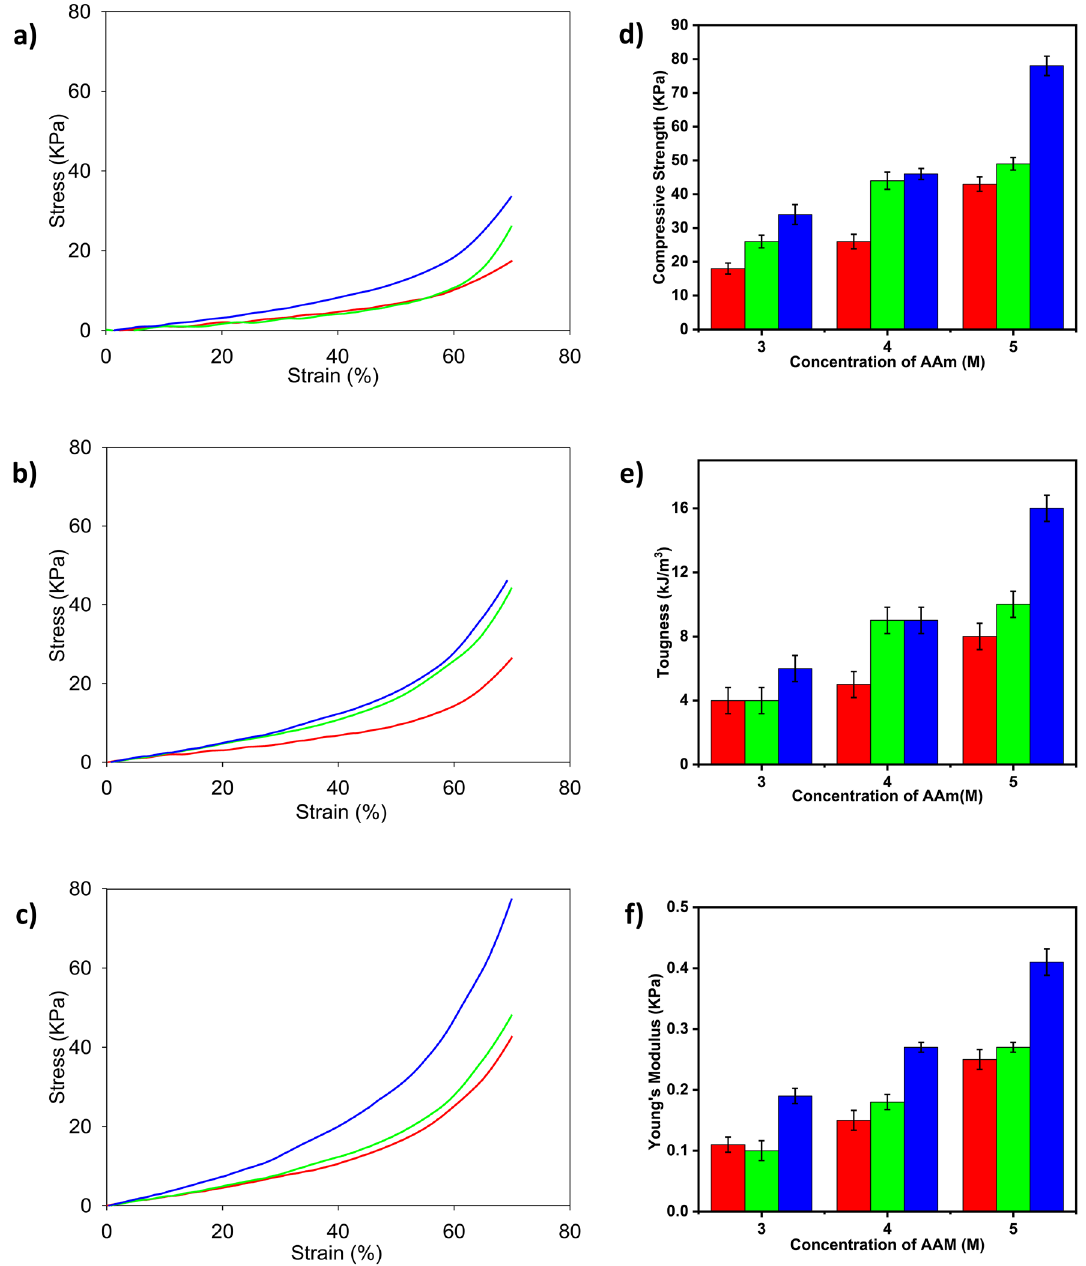
Figure 8. Stress–strain curves produced by compressive strength test of PAAm (3 M)-MSiO 2 0.75% ( a ), PAAm (4